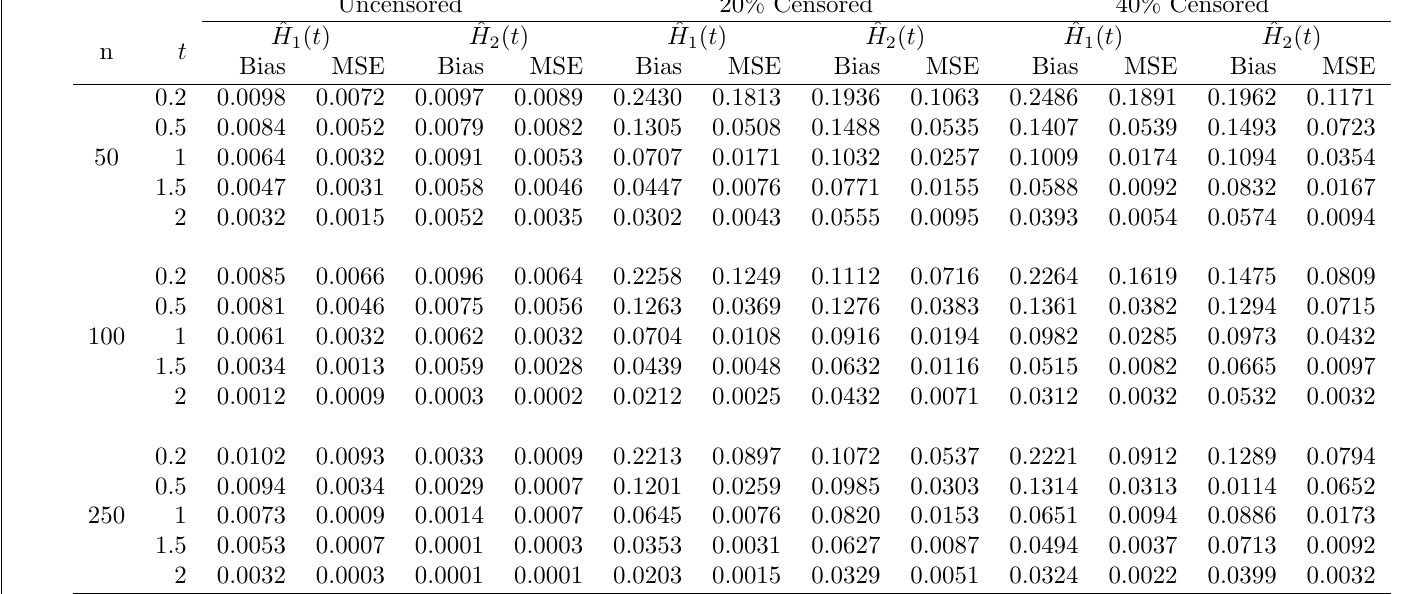
Bias and MSE of the estimates of H 1 ( t ) and H 2 ( t ) for a = 1 . 5 , ϕ = 0 . 4 and λ = 0 .